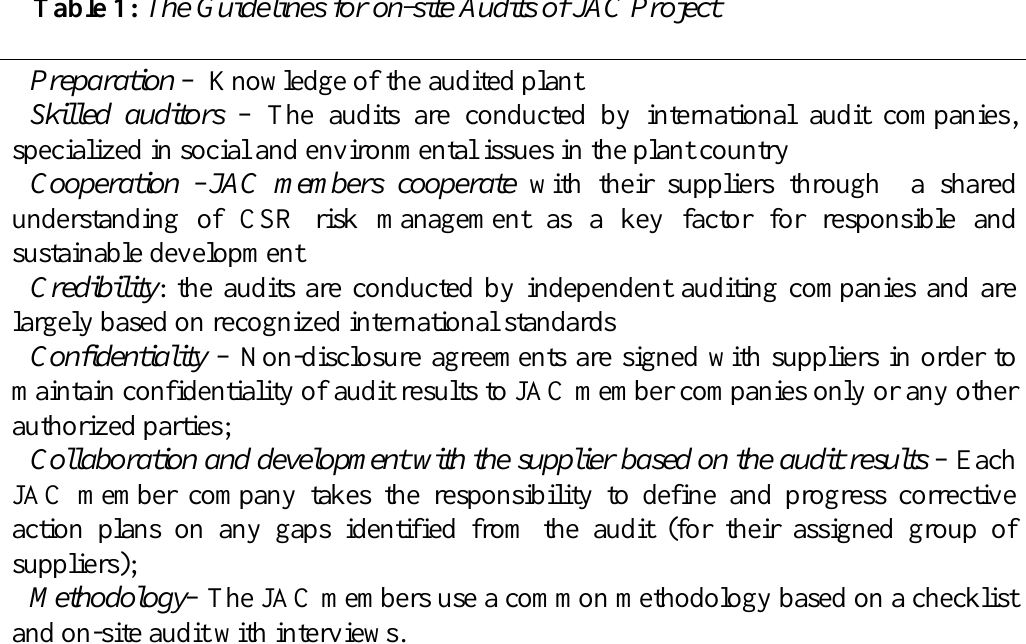
Table 1: The Guidelines for on-site Audits of JAC